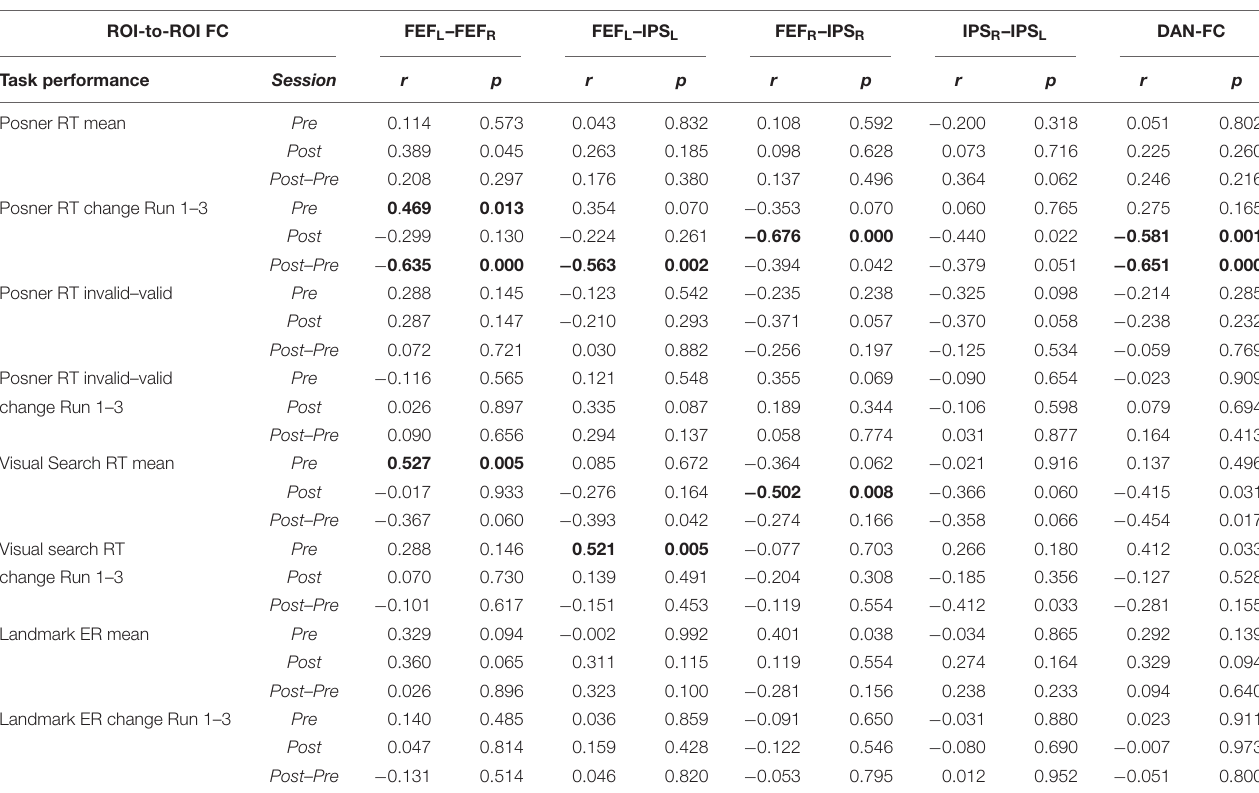
TABLE 2 | Overview of all FC–behavior